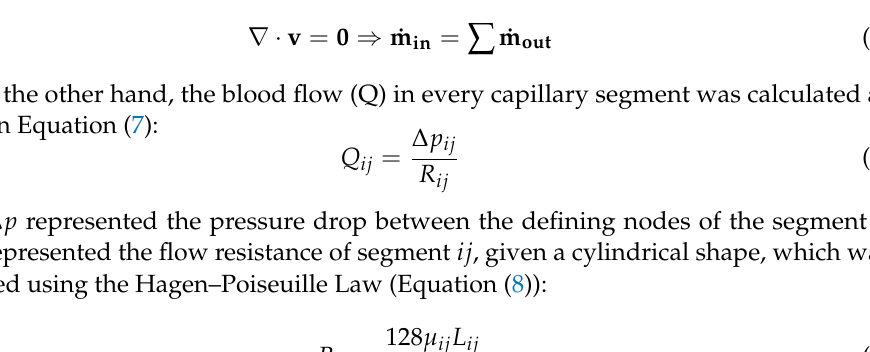
where L ij was the total segment length divided by k intermediate segments. Initially, the mass flow entering a node was the same as the outflow of this node, fulfilling the continuity equation in every geometry node (Equation